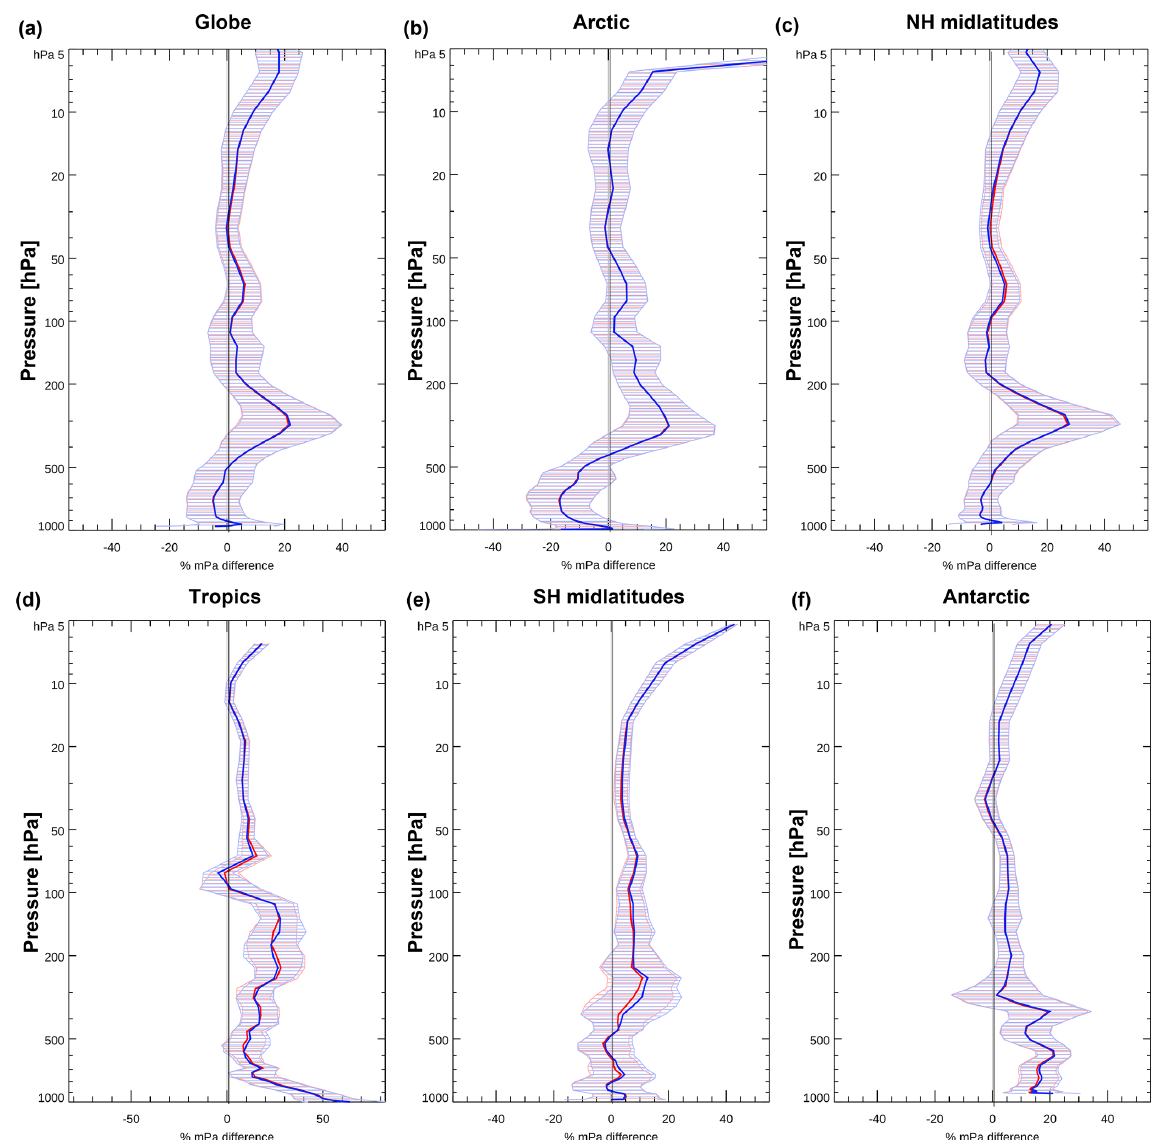
Figure 12. Mean relative O 3 bias for FMA 2018 in percent between ASSIM (red) and CTRL (blue) and ozone sondes averaged over the (a) globe, (b) Arctic, (c) NH midlatitudes, (d) tropics, (e) SH midlatitudes and (f)